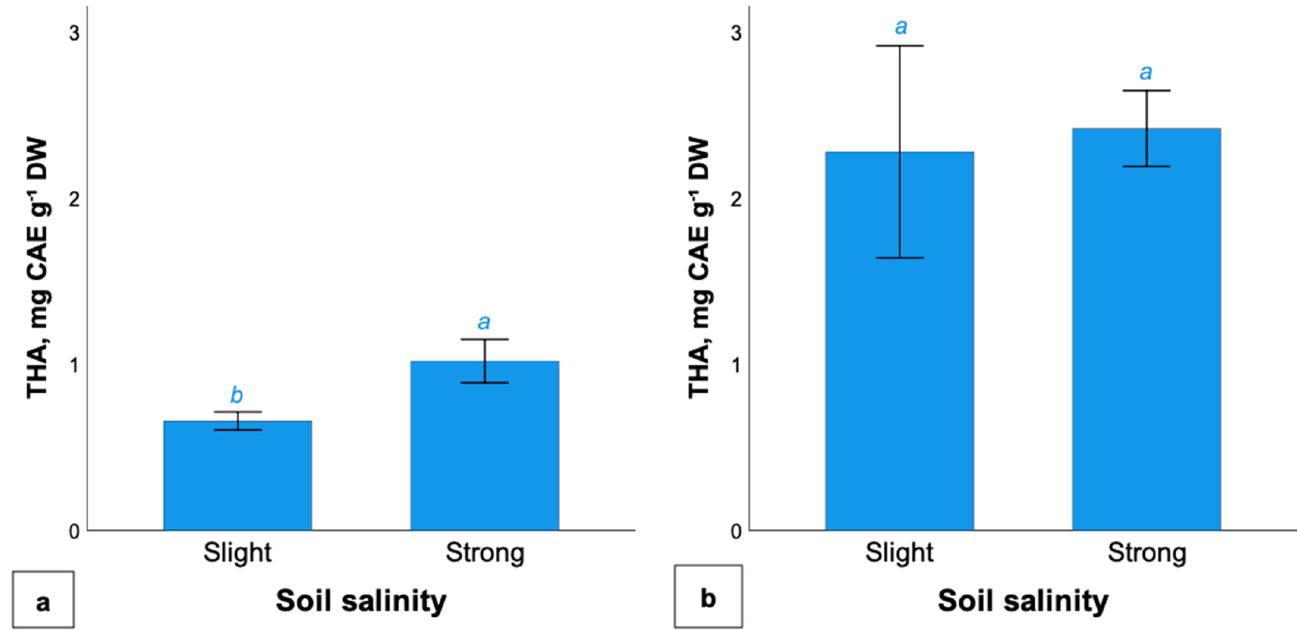
Figure 3. Total hydroxycinnamic acids in roots ( a ) and shoots ( b ) of G. maritima at different levels of soil salinization. Different letters indicate significant differences among the different levels of soil salinity ( t ‐ test, p ≤ 0.05).